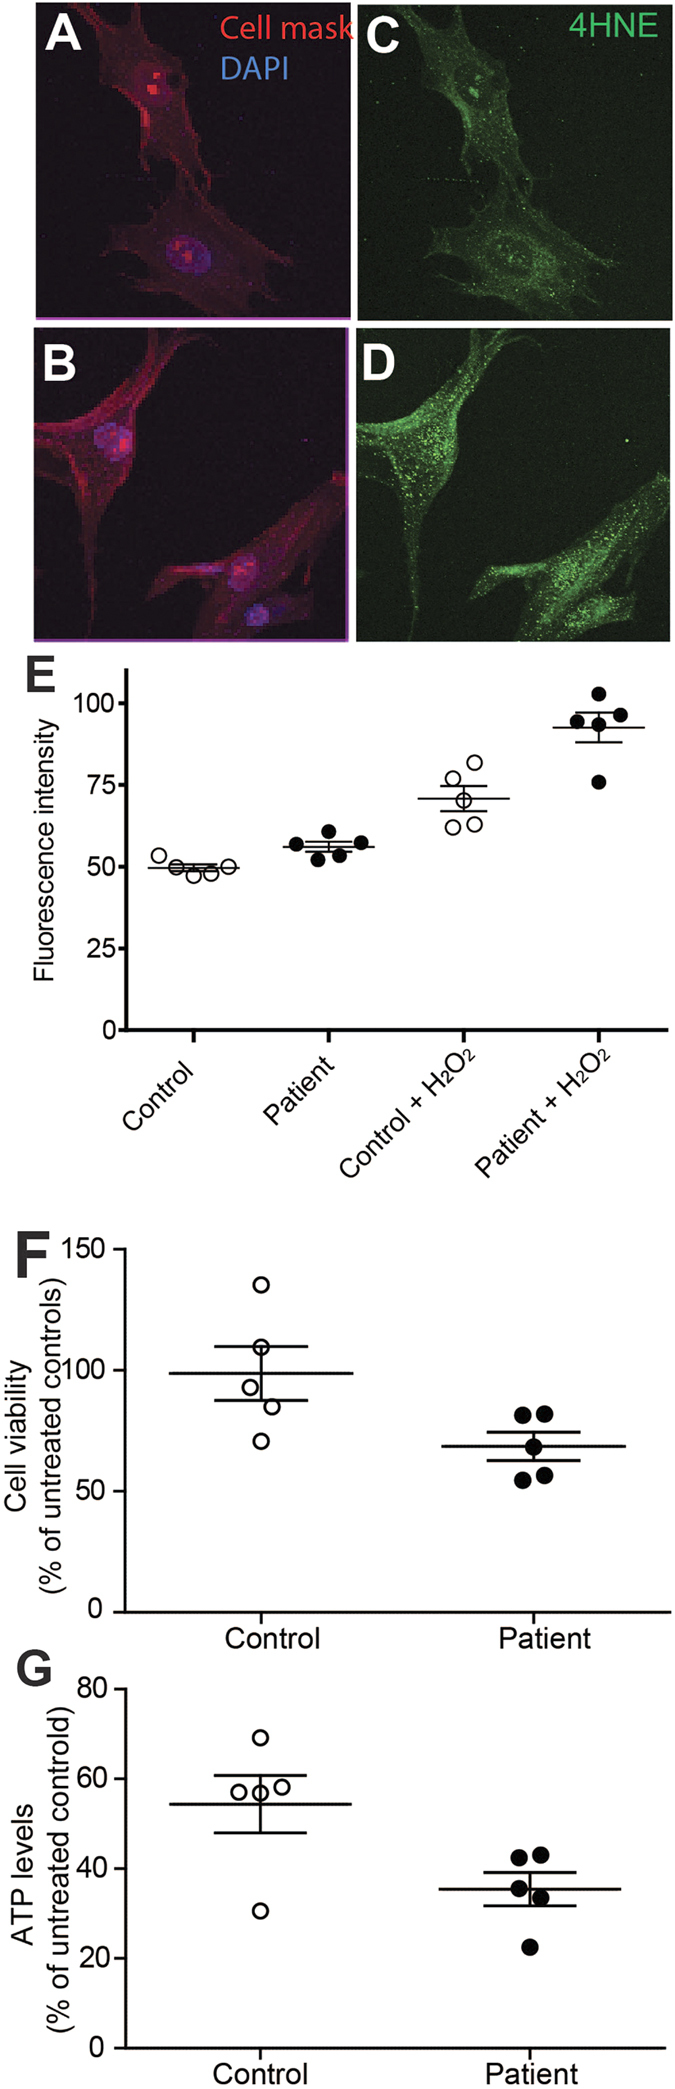
Patient cells were under oxidative stress.(A,B) Control (A) and patient (B) ONS cells (cytoplasm, red, Cell mask; nucleus, DAPI, blue). (C,D) Control (C) and patient (D) ONS cells immunostained for the oxidative stress marker (4HNE, green). (E) 4HNE fluorescence in cells cultured under baseline conditions (Control, Patient) and 1 hour after 50 μm hydrogen peroxide (Control + H2O2, Patient + H2O2). N = 1977 control cells at baseline; 1027 control cells post H2O2 exposure; 2022 patient cells at baseline and 1003 patient cells post H2O2 exposure. Average 4HNE fluorescence values of all patient cell lines (solid circles) were compared to all control cell lines (open circles). The fluorescence intensity was significantly different among the groups (repeated measures ANOVA; control v/s patient: p = 0.002; effect of hydrogen peroxide: p < 0.001 and interaction between disease status and treatment: p = 0.042). (F) Quantification of cell viability with MTS assay. Average cell viability values measured by MTS assay for all patient cell lines (solid circles) were compared to all control cell lines (open circles). N = 5 cell lines per group. Unpaired t-test; two tailed; p-value: 0.0429; t = 2.404 df = 8. Data are represented as Mean ± SEM. (G) Quantification of ATP production with ATPlite assay. Average ATP values measured by ATPlite assay for all patient cell lines (solid circles) were compared to all control cell lines (open circles). N = 5 cell lines per group. Unpaired t-test; two tailed; p-value: 0.0336; t = 2.562 df = 8. Data are represented as Mean ± SEM.